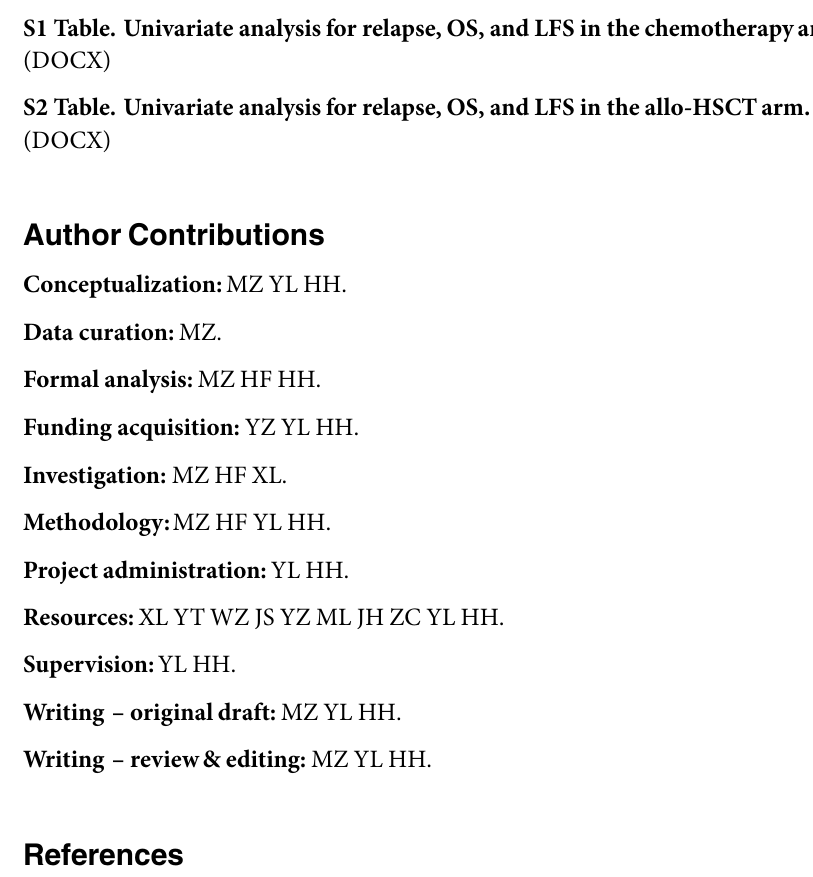
S1 Table. Univariate analysis for relapse, OS, and LFS in the chemotherapy arm. S2 Table. Univariate analysis for relapse, OS, and LFS in the allo-HSCT